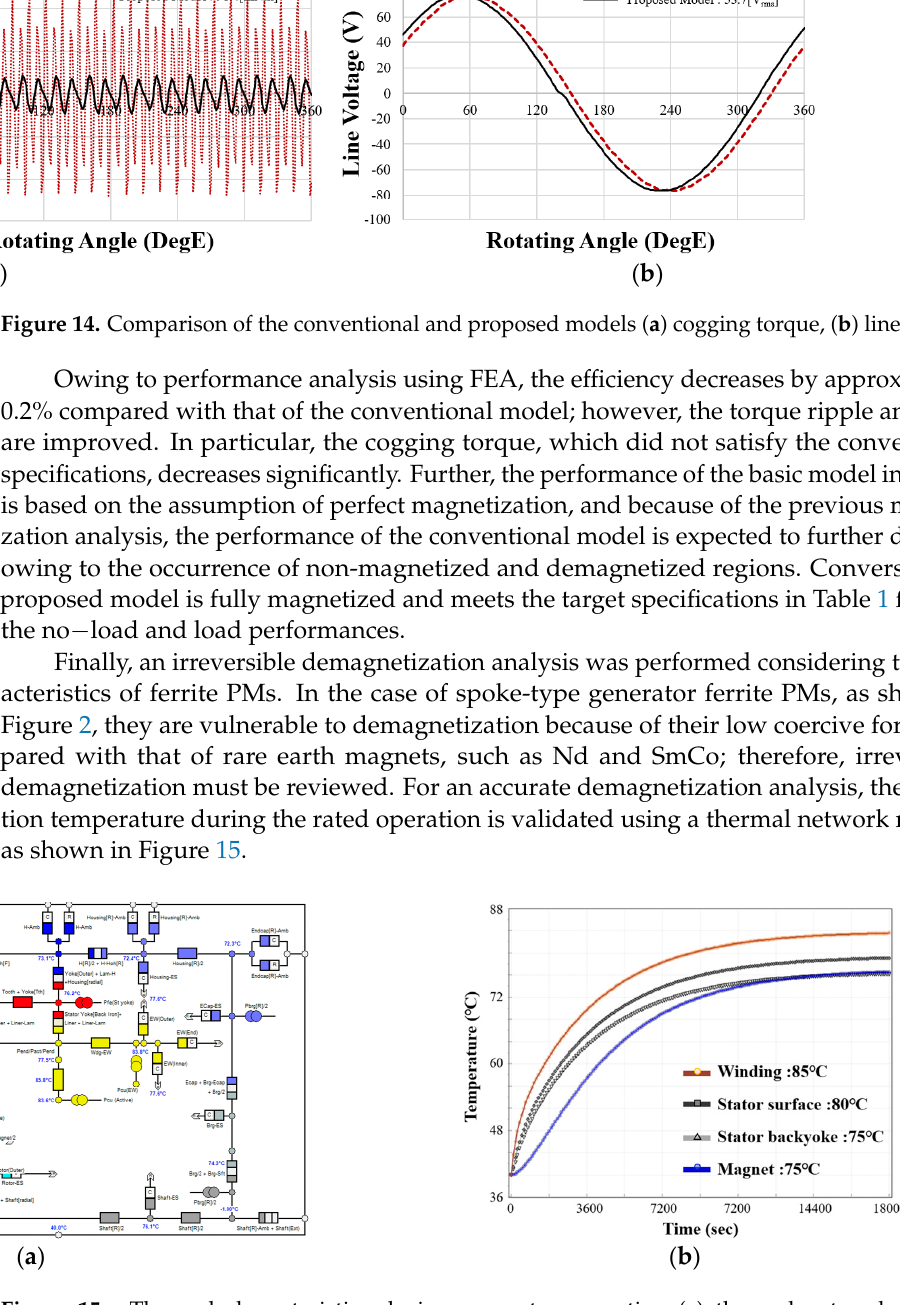
Figure 15. Thermal characteristics during generator operation ( a ) thermal network method, ( b ) temperature saturation graph for each generator part.